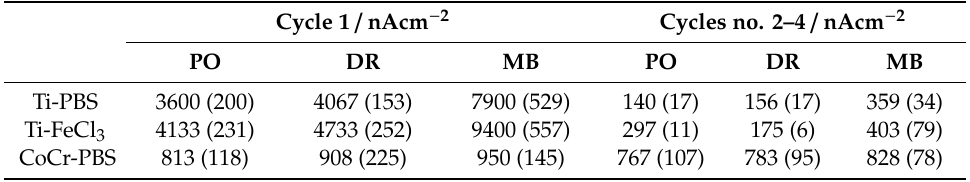
Table 2. Passive current densities (mean (SD)) during first anodic polarization cycles and anodic polarization cycles no. 2–4 of polished, deep-rolled and microblasted Ti6Al4V and CoCrMo samples.